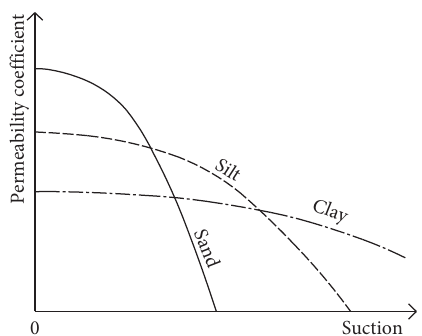
Figure 3: Diagram of the change in soil permeability coefficient with